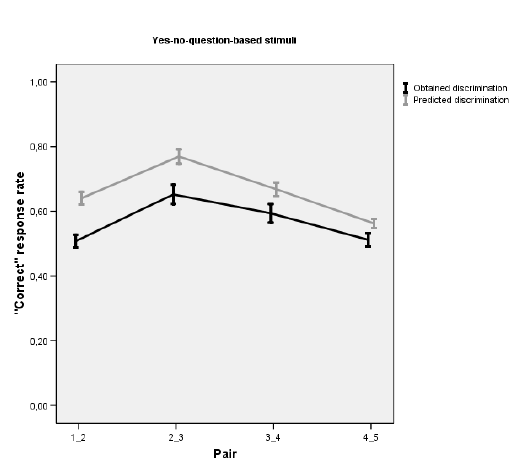
Figure 8. Predicted and obtained discrimination rates for the continuum created from the yes-no question base stimulus. Error bars represent the standard error of the mean.